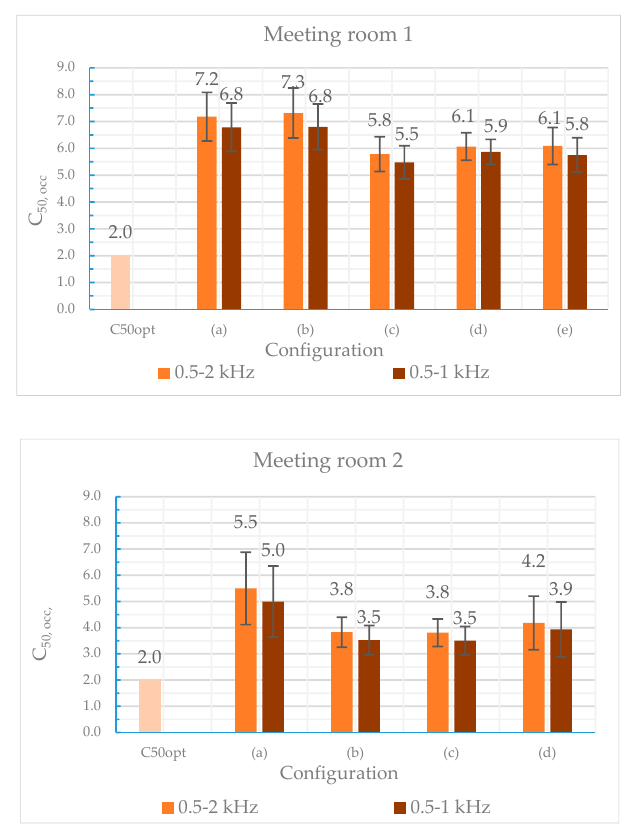
Figure 12. Spatial average value of Clarity C 50,0.5–2 kHz and C 50,0.5–1 kHz in the Mr1 and Mr2 simulated with ODEON 15 for the different configurations shown in Figures 5 and 6, and optimal minimum value in unoccupied conditions, C 50opt . The error bars represent the standard deviation across different measurement positions.